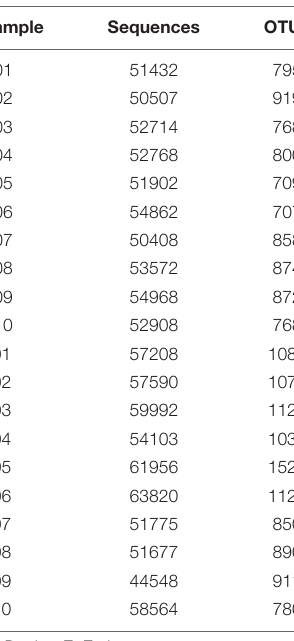
TABLE 1 | Sequencing information and diversity index of bacteria in